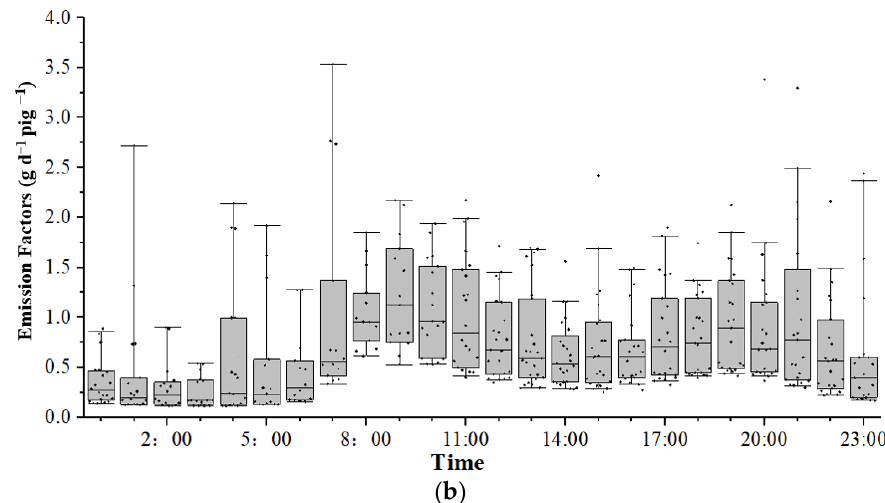
Figure 8. Diurnal variation of NH 3 emission inside the pig house. ( a ) Winter; ( b ) Summer.